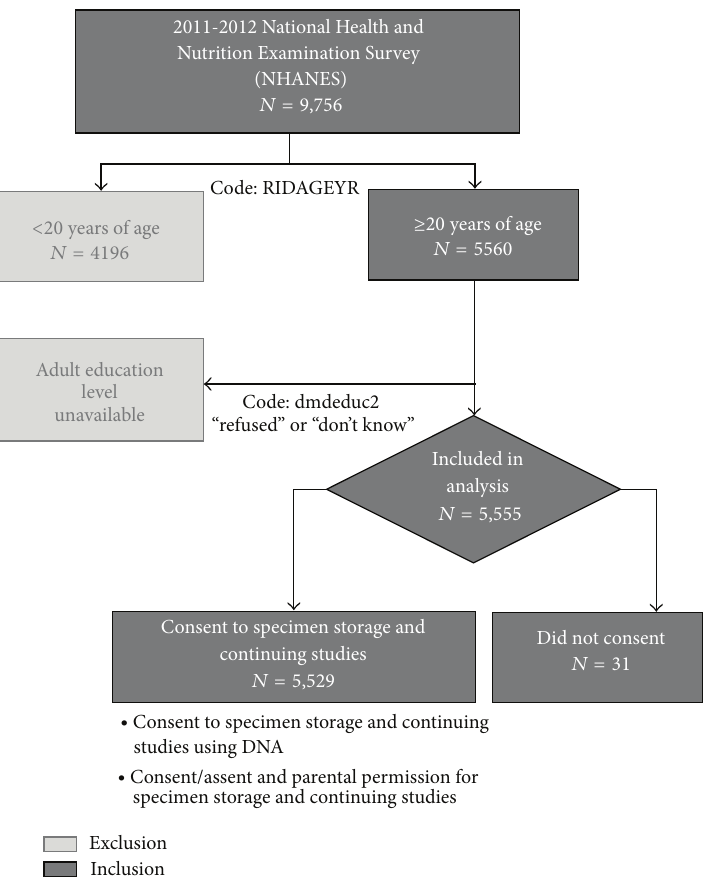
Figure 1: Participant selection process for data analysis, 2011-2012